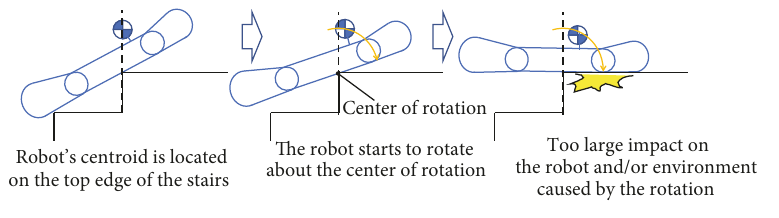
Figure 6: Excessive